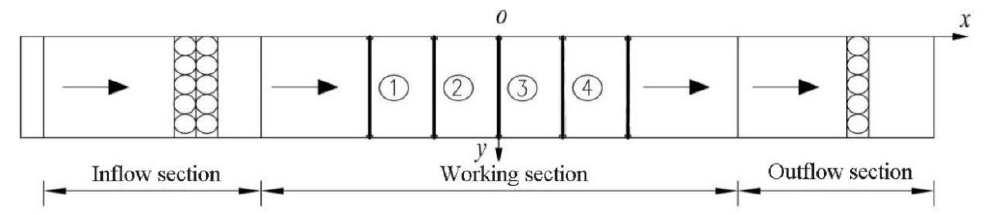
Figure 2. Sketch and coordinates definition of the flat-crested weir-type fishway flume.